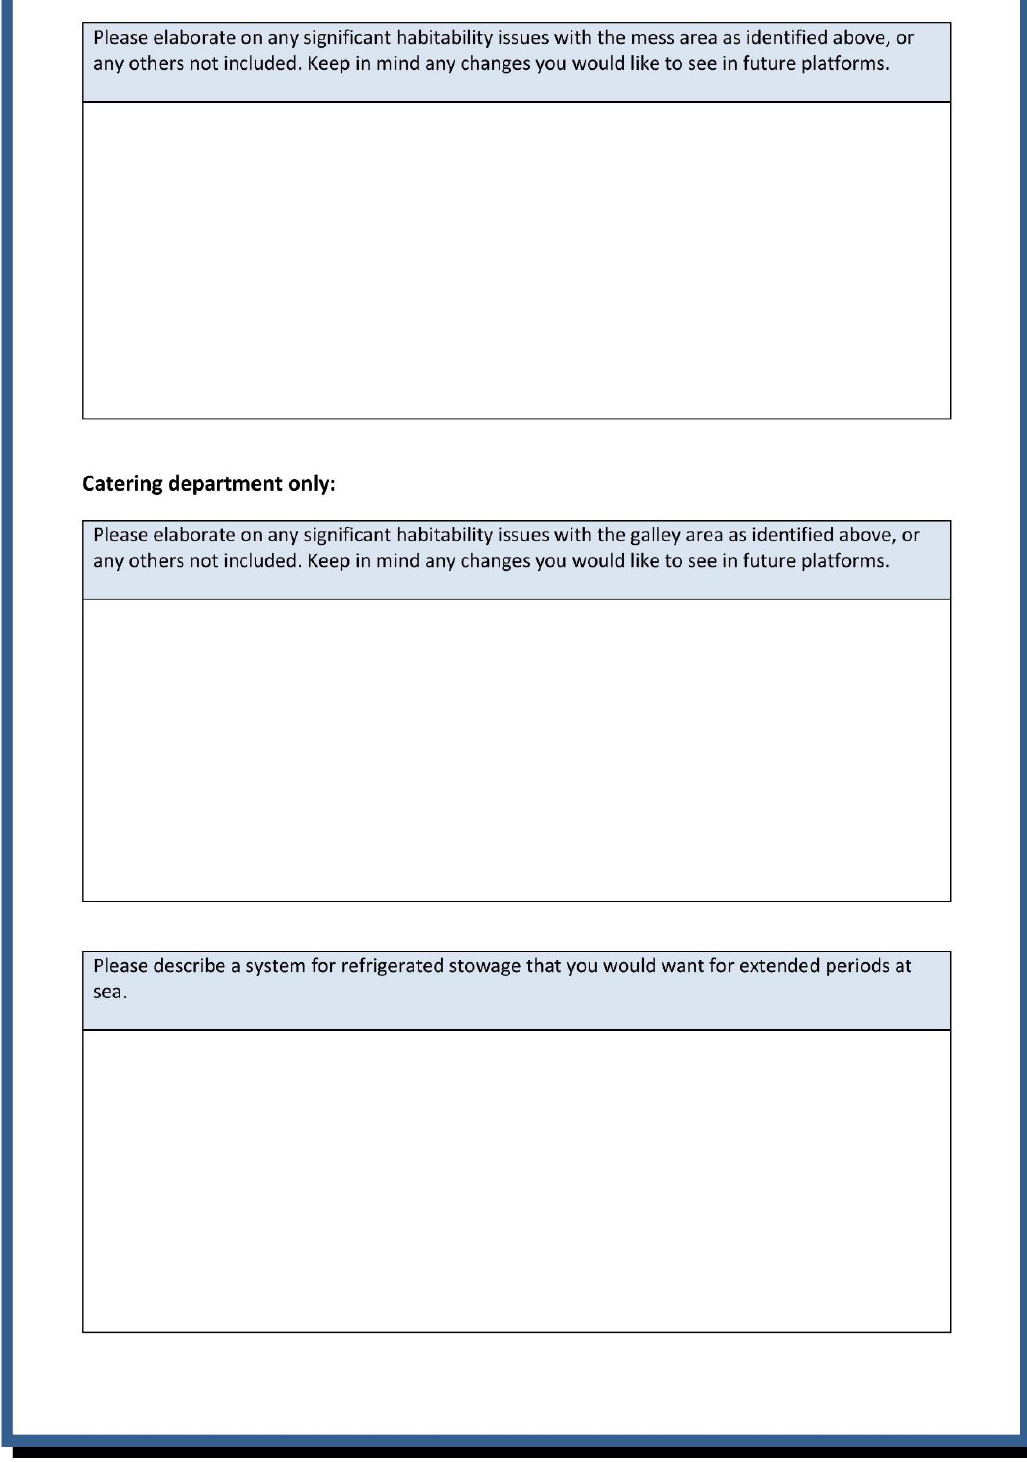
Figure A7. The Submarine Habitability Assessment Questionnaire (continued).